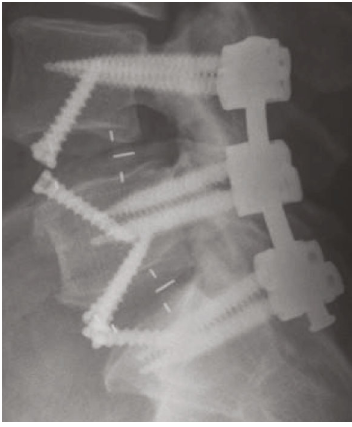
Figure 4: Postoperative lateral X-ray.